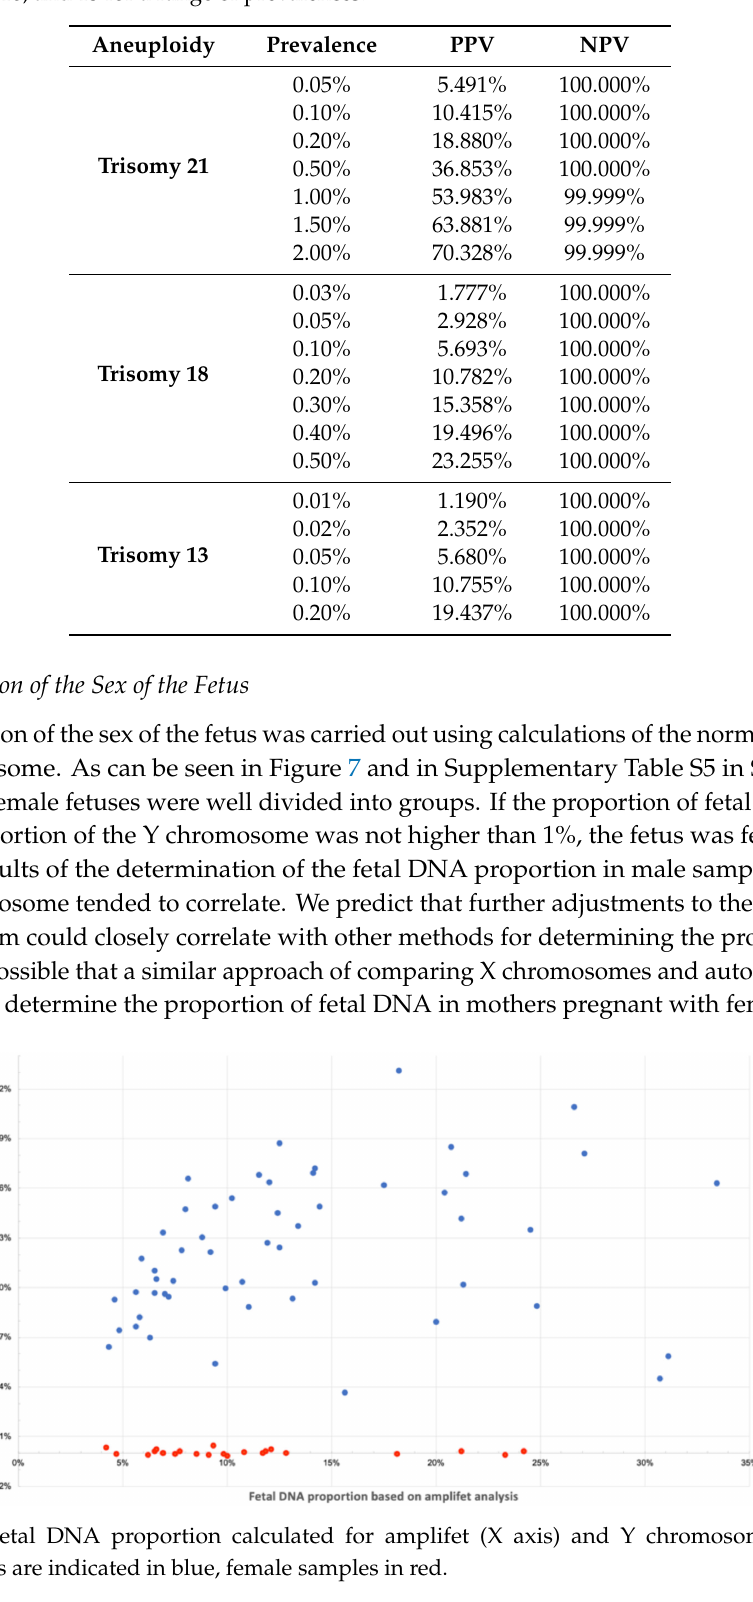
Table 4. Positive predictive value and negative predictive value of our NIPT assay for detecting trisomies 21, 18, and 13 for a range of prevalences.